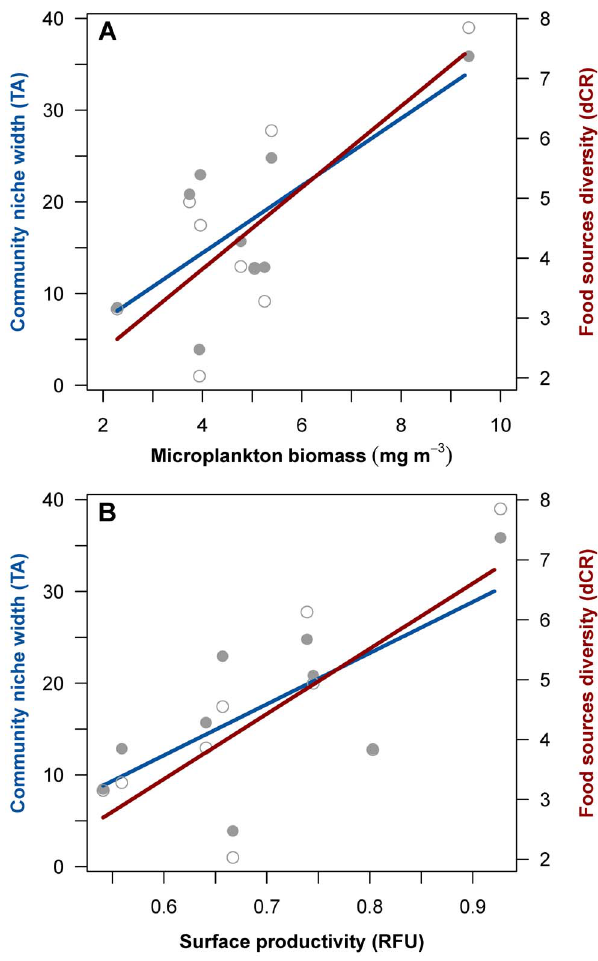
Figure 3. Surface modulation of deep trophic dynamics. Scatterplots showing the correlation between surface microplankton biomass (A) and surface productivity (B, estimated by fluorescence) against benthic trophic parameters: community niche width (TA, filled circles) and food sources diversity (dCR, open circles).